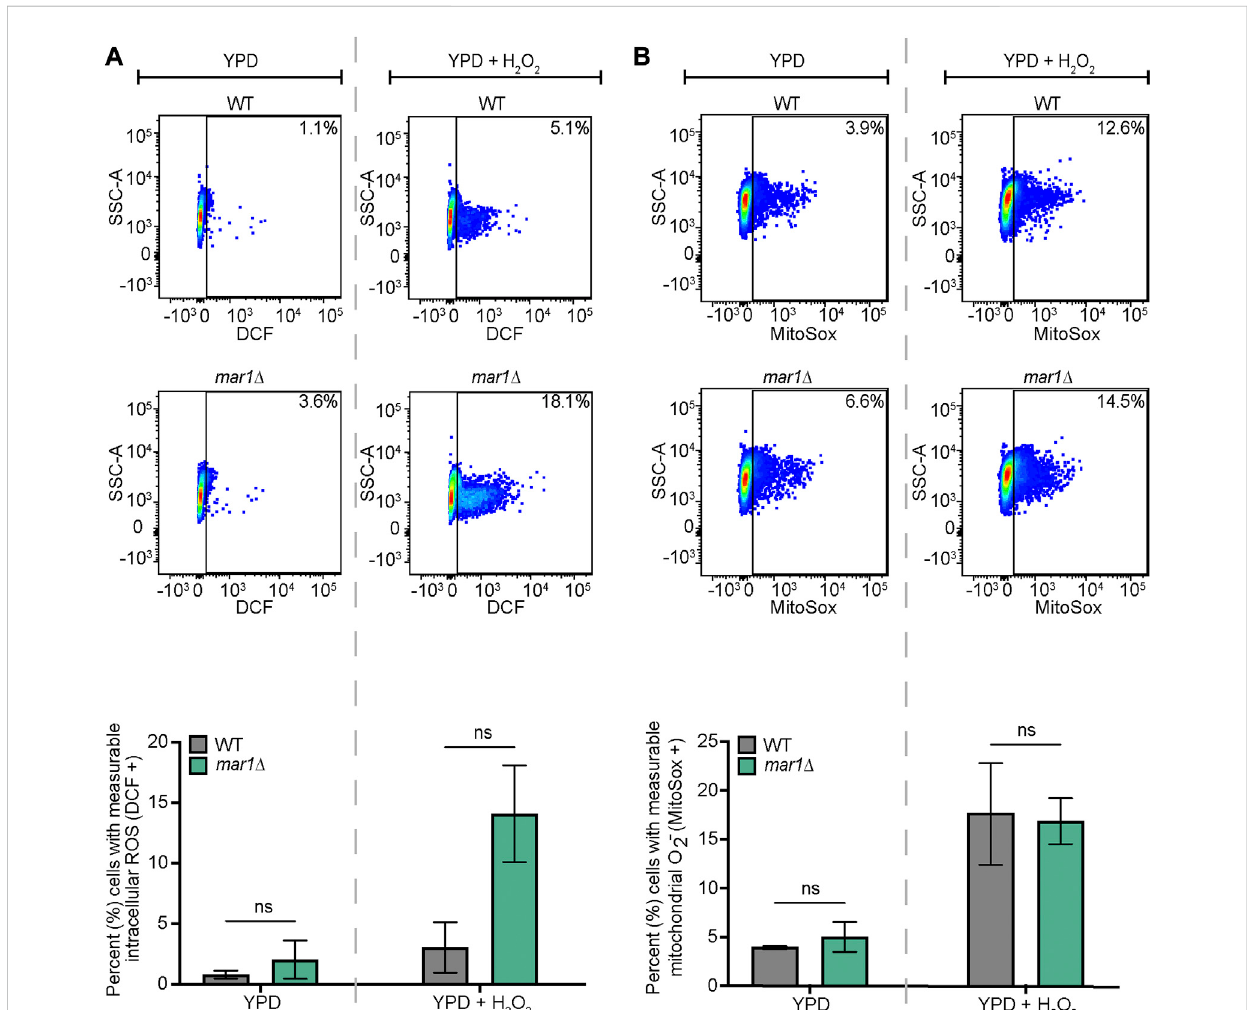
FIGURE 7 Mar1 contributions to intracellular ROS levels. (A) Total intracellular ROS was measured for the WT strain and the mar1 Δ mutant strain following incubationintheabsenceandpresenceofhydrogenperoxide(H 2 O 2 )(0.01%).Cellswerestainedwith2 ′ ,7 ′ -dichlorodihydro fl uoresceindiacetate(DCF)as a marker for intracellular ROS. Flow cytometry was used to quantify staining intensity. Relevant events were gated for live cells (FSC vs. SSC), single cells (FSC-H vs.FSC-A),and positivelabelling(SSCvs.DCF,determinedusingunstainedcellsas negativecontrols). Dataare representedasdot plotswith mean fl uorescenceintensityonthex-axisandSSC-Aonthey-axis,withpercentagesofcellsdisplayingDCFstainingincluded.Theaveragepercentageof cells displaying DCF staining across two biological replicates ( n = 2)is also included. Error bars represent theSEM. Statistical signi fi cance was determined using two-way ANOVA and the Tukey-Kramer test (ns, not signi fi cant). (B) Mitochondrial superoxide was measured for the WT strain and the mar1 Δ mutantstrainfollowingincubationintheabsenceandpresenceofhydrogenperoxide(H 2 O 2 )(0.01%).CellswerestainedwithMitoSoxRedasamarkerfor mitochondrialsuperoxide.Flowcytometrywasusedtoquantifystainingintensity.Relevanteventsweregatedforlivecells(FSCvs.SSC),singlecells(FSC- H vs. FSC-A), and positive labelling (SSC vs. MitoSox Red, determined using unstained cells as negative controls). Data are represented as dot plots with mean fl uorescence intensity on the x-axis and SSC-A on the y-axis, with percentages of cells displaying MitoSox Red staining included. The average percentage of cells displaying MitoSox Red staining across two biological replicates ( n = 2) is also included. Error bars represent the SEM. Statistical signi fi cance was determined using two-way ANOVA and the Tukey-Kramer test (ns, not signi fi cant). O 2 − ,